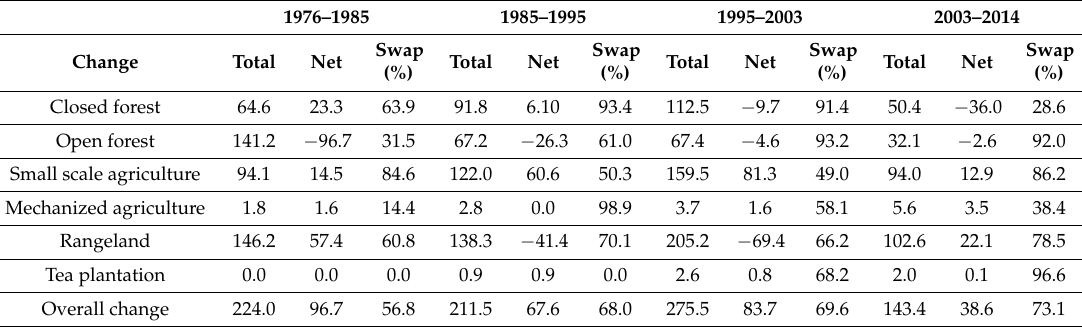
Table 1. Categories of annual land change (km 2 /year) during the four